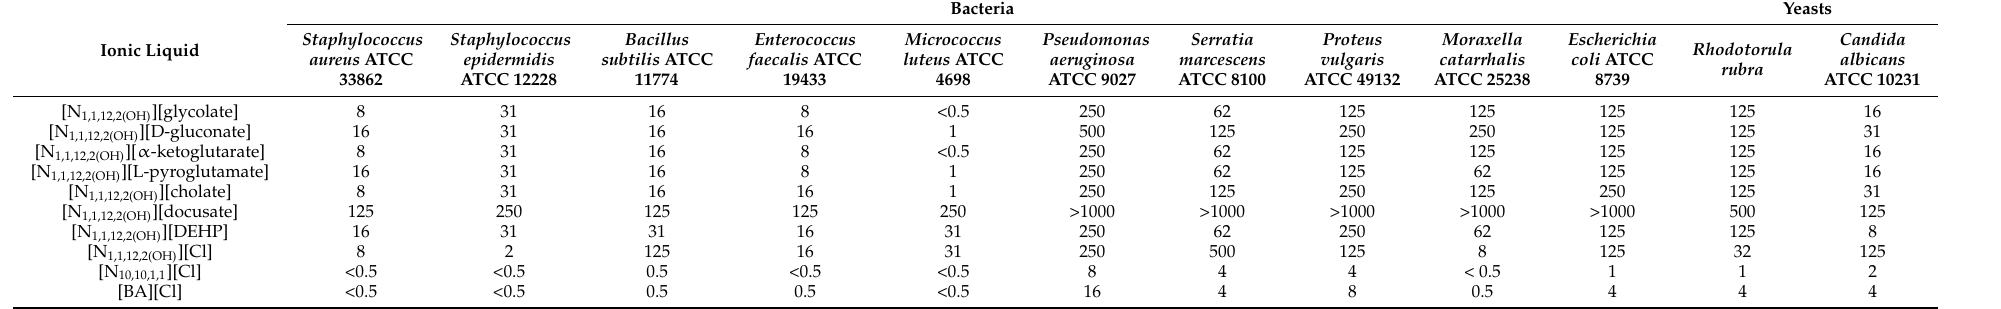
Table 2. MIC values ( µ g · cm − 3 ) obtained in work developed by Kaczmarek et al.